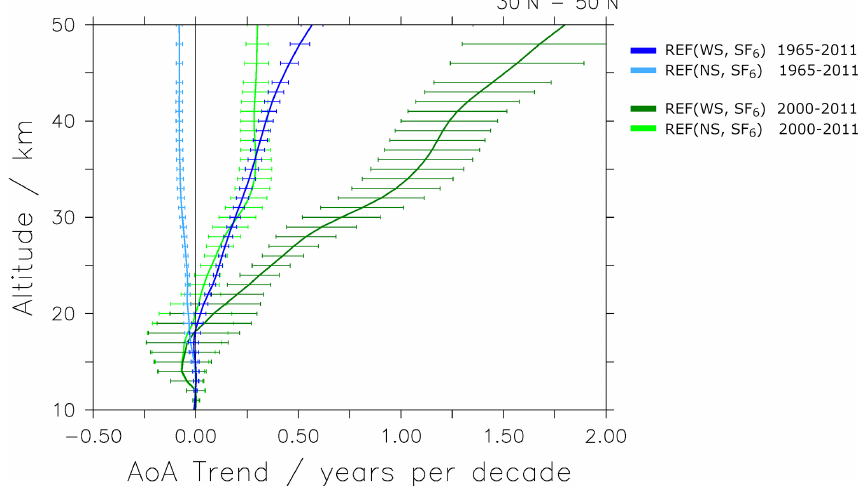
Figure 5. Vertical profile of the linear trends of AoA(WS, SF 6 ) REF and AoA(NS, SF 6 ) REF over 30–50 ◦ N, calculated for the 1965–2011 and 2000–2011 time periods. Error bars depict the 2 σ standard deviation of the trend over the respective time period, and the black vertical line denotes the zero line.